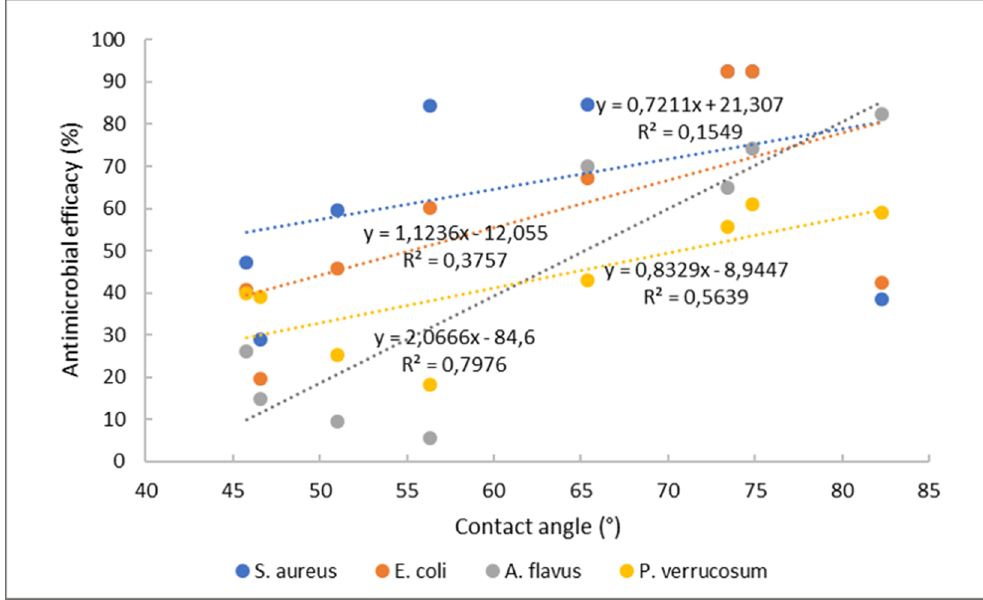
Figure 6. Correlation between contact angle and antimicrobial efficacy.